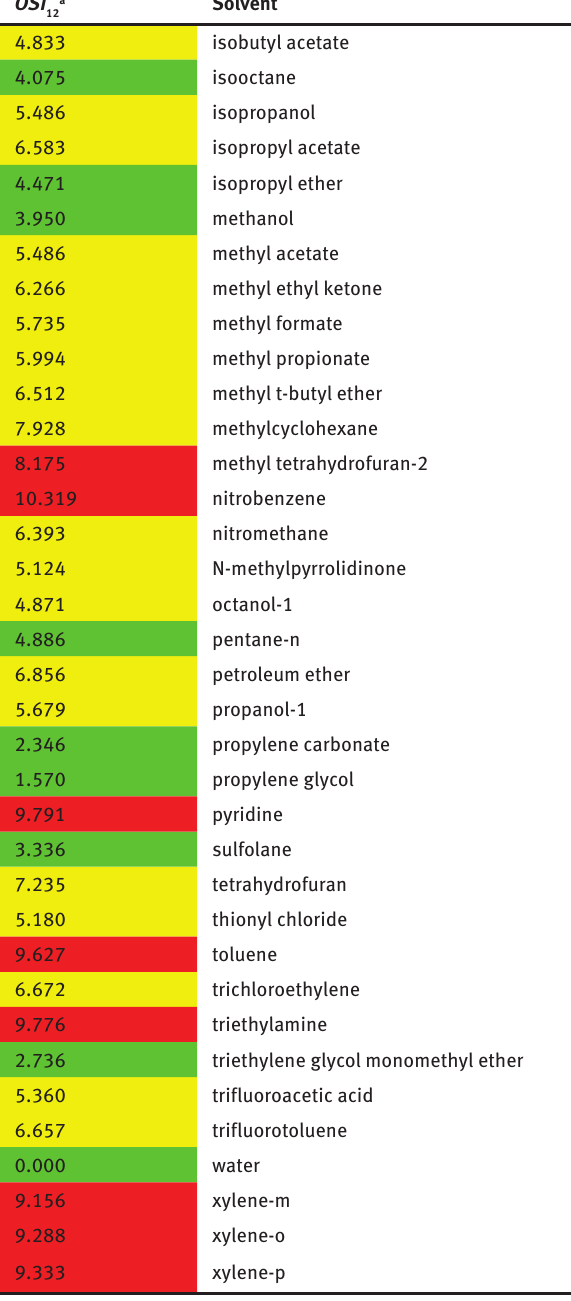
a Green colour indicates benign performance ( OSI indicates intermediate performance (5 < OSI indicates worst performance ( OSI